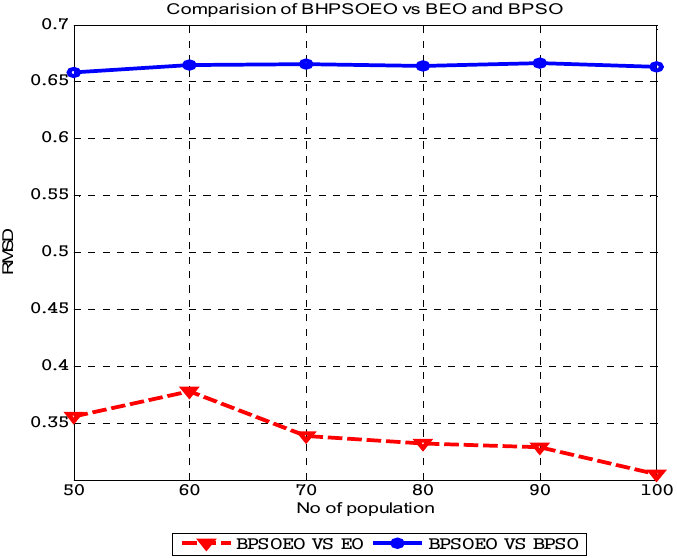
Figure 10. RMSD in average fitness for BPSOEO versus BEO and BPSO in the cryptanalysis of RC4 cipher when text length is 128 bits.